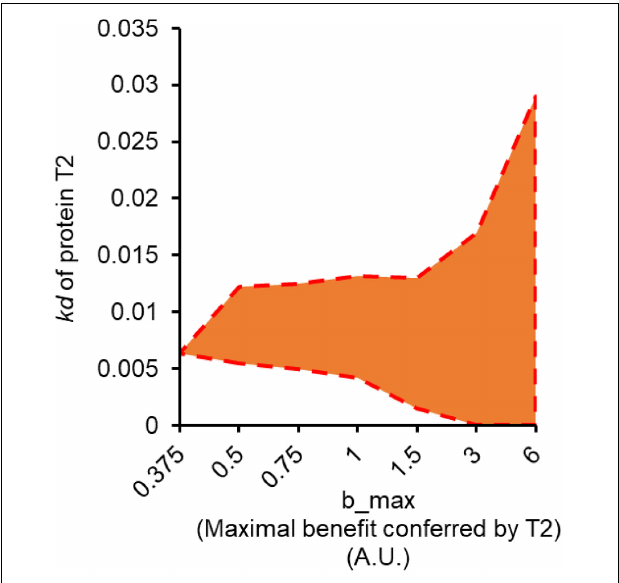
FIGURE 3 | Anticipatory regulation emerges as optimal solution as maximum benefit conferred by T2 increases. The shaded region in orange represents the range of the values of kd for protein T2, for which anticipatory regulation is the optimal regulatory design, at a given value of b max